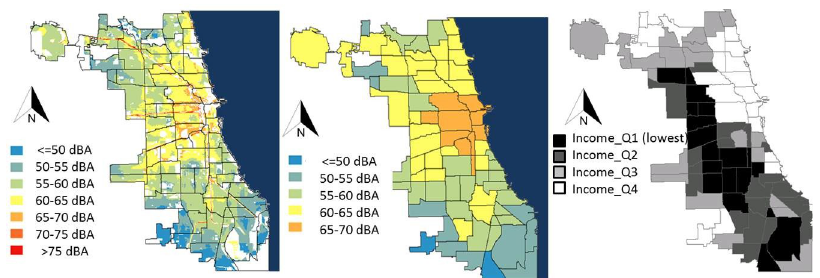
Fig 1. Predicted daytime noise level in the city of Chicago, IL at the census block (left) and community level (middle), compared to community per capita income (right). Black lines denote the 77 communities.